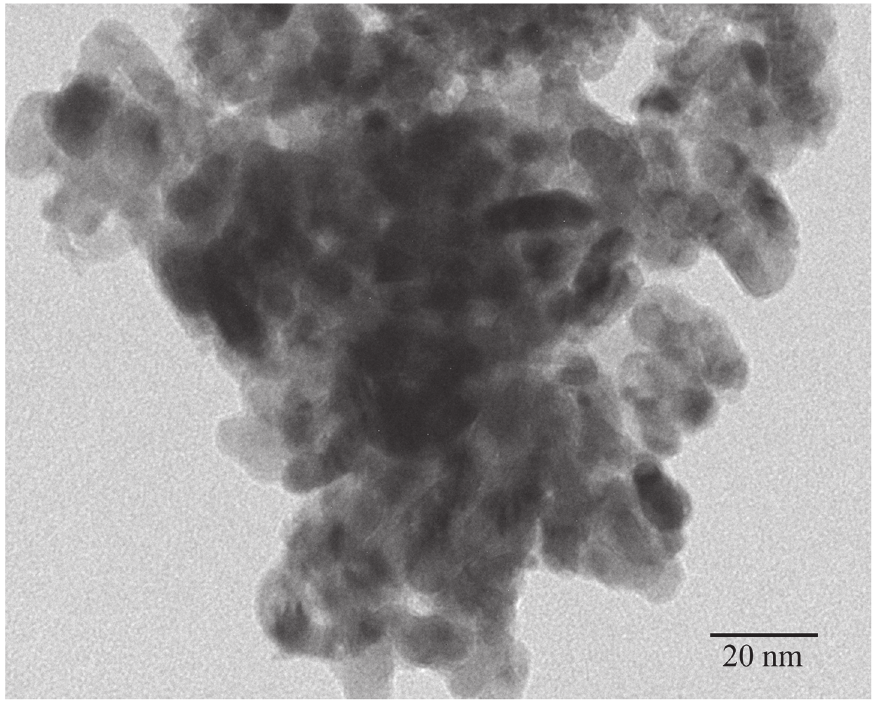
Fig 1. Transmission electron microscope (TEM) image of anatase TiO 2 NPs